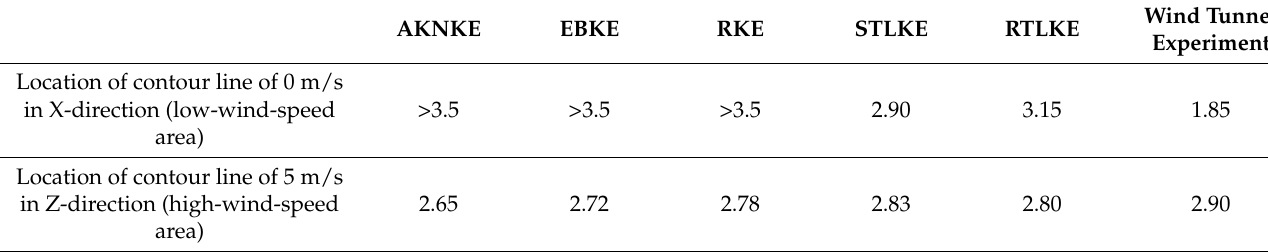
Table 4. Location of contour line at Y = 0 ( U